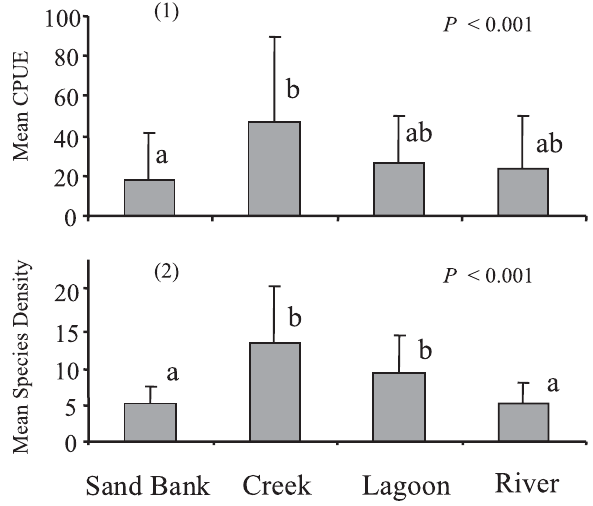
Fig. 1 . Mean (1) CPUE (catch per unit effort) and (2) spe- cies density in the four habitat types. Error bars are 1 S.D. Letters next to habitat types represent results of Dunn’s post-hoc test for differences in mean values between each habitat pair.